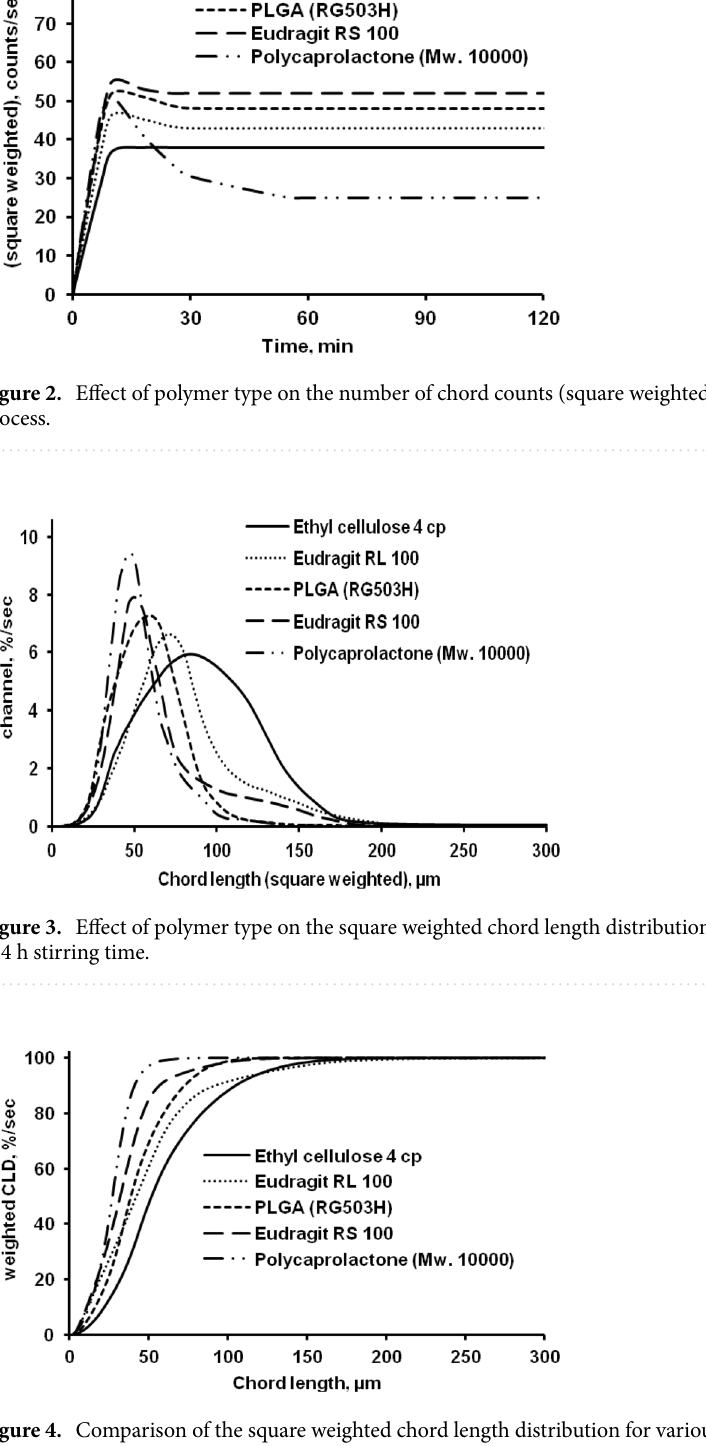
Figure 4. Comparison of the square weighted chord length distribution for various polymer obtained by the FBRM method (O/W) at 4 h stirring